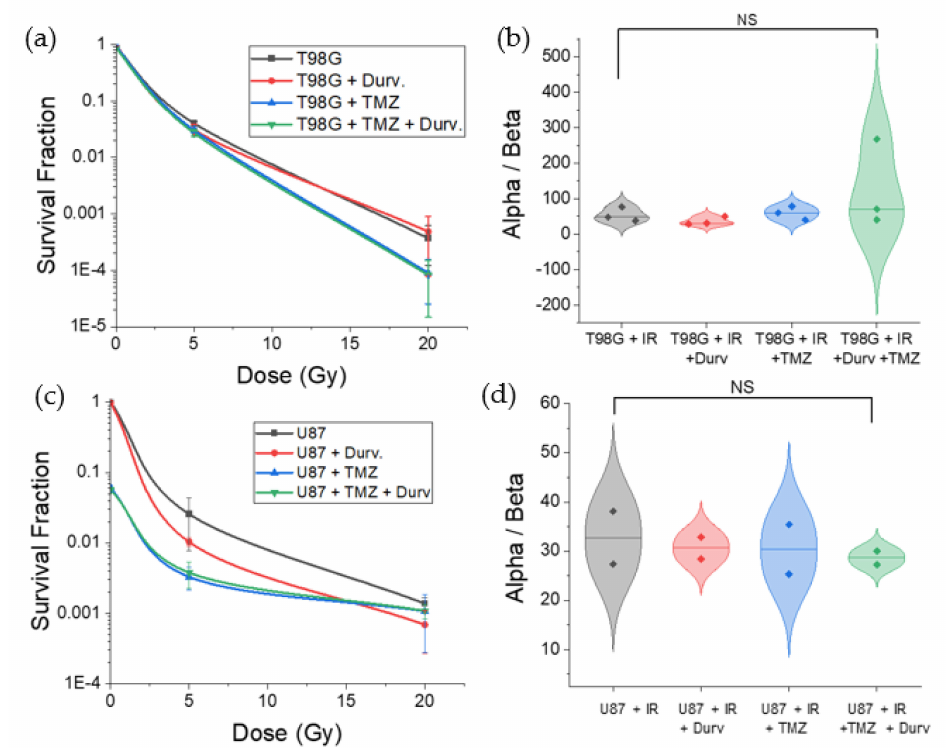
Figure 8. Survival curve and calculated alpha/beta ratio. ( a ) Survival curve for T98G cells treated with radiation at 0, 5, and 20 Gy alone, with concurrent temozolomide, durvalumab, and both. ( b ) Calculated alpha/beta ratio for ( a ). ( c ) Survival curve for U87G cells treated with radiation at 0, 5, and 20 Gy alone, with concurrent temozolomide, durvalumab, and both. ( d ) Calculated alpha/beta ratio for ( c ). Overall, increased radiation dose led to greater cell death ( p < 0.001) for both cell lines. The addition of each agent to radiation showed no significant change to cell survival relative to the radiation-only conditions for T98G, but for U87, the addition of TMZ decreased cell survival ( p < 0.0001) at 0 Gy, and marginally, but not significantly, decreased cell survival at higher radiation doses. NS